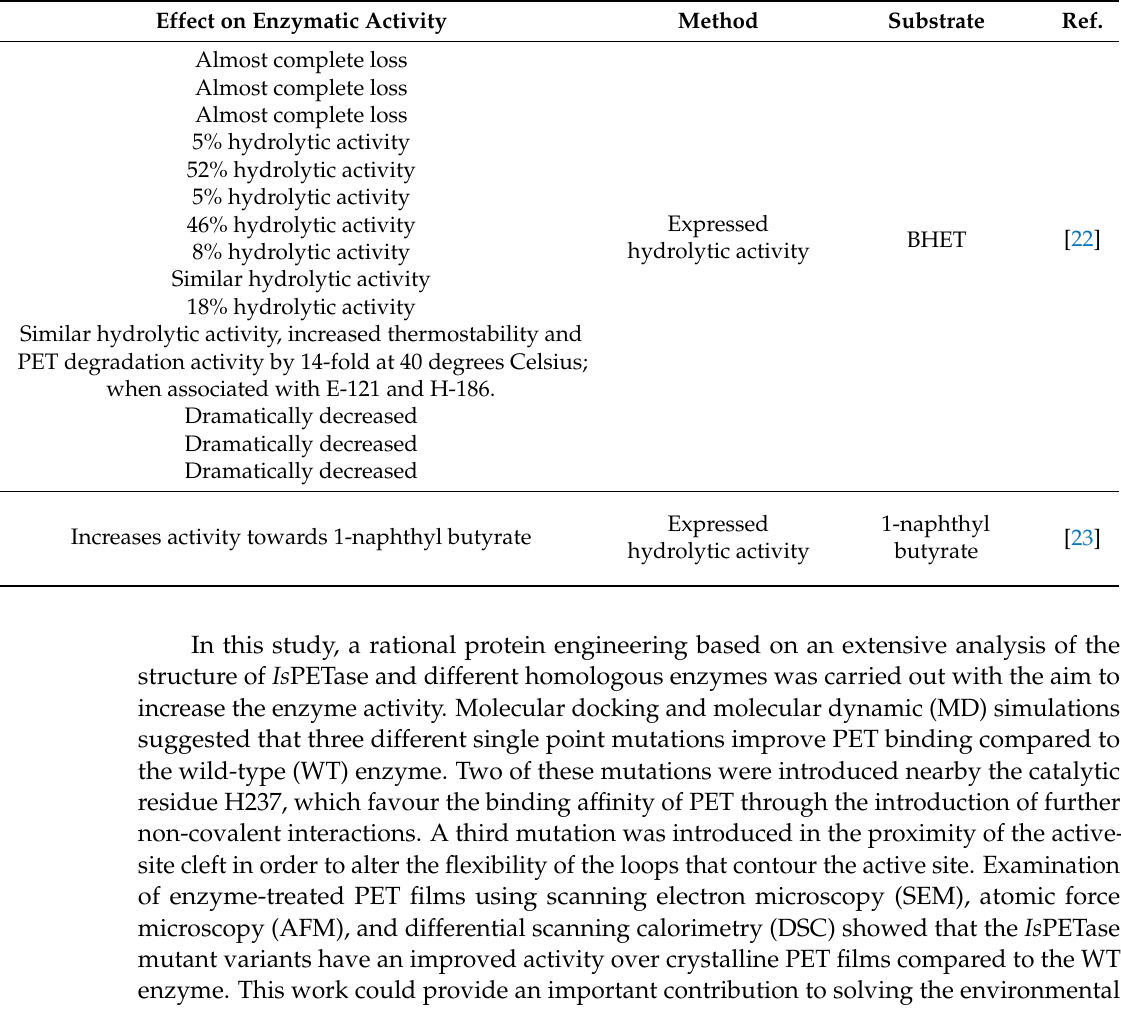
Table 2. Mutations of Is PETase structure for modifying its PET-degrading